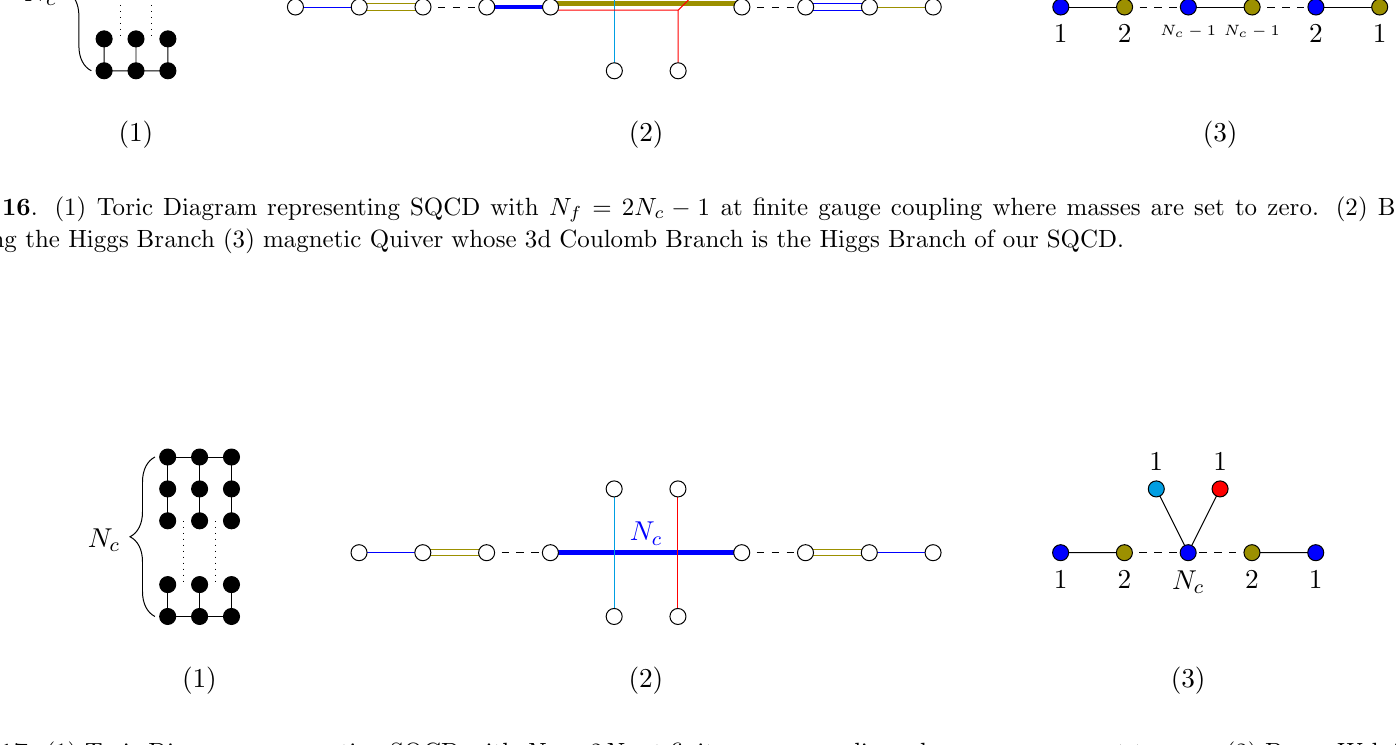
Figure 17 . (1) Toric Diagram representing SQCD with N f = 2 N c at finite gauge coupling where masses are set to zero. (2) Brane Web indicating the Higgs Branch (3) magnetic Quiver whose 3d Coulomb Branch is the Higgs Branch of our